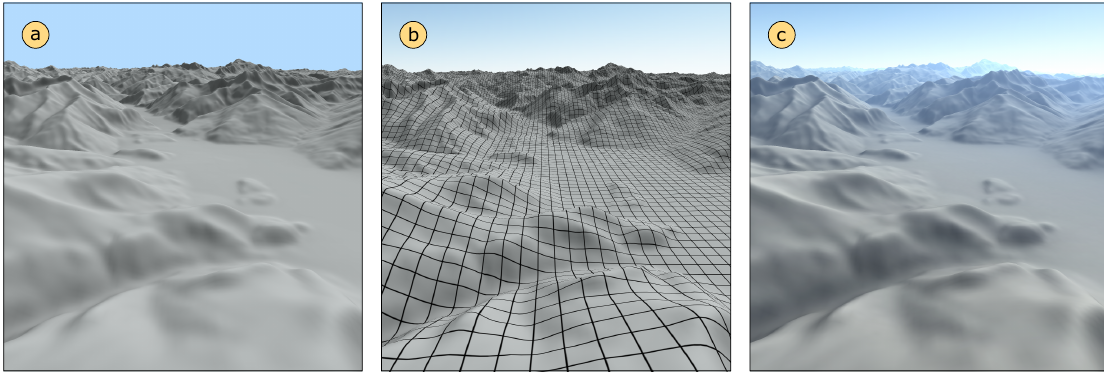
Figure 6. Enhancing distance awareness within terrain model. In ( a ) the terrain is represented without depth cues; ( b ) uses a regular grid; and, in ( c ), aerial perspective is